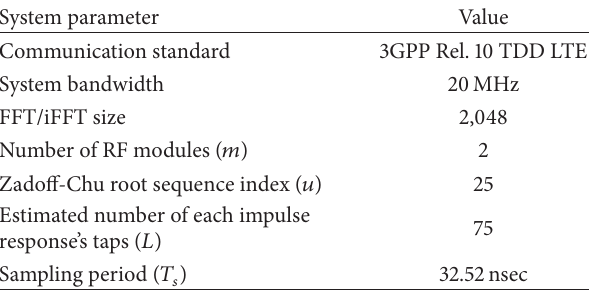
Figure 7: Detailed diagram of Frame Synchronization.